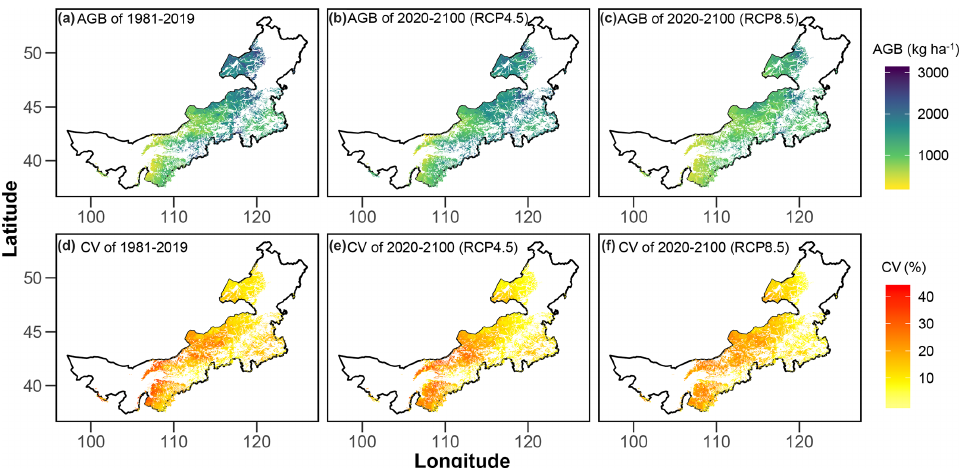
Figure 5. Spatial patterns of Inner Mongolian grassland aboveground biomass (AGB) and the uncertainties in terms of coefficient of varia- tions (CV). The upper panels show the average gridded AGB over 1981–2019 (a) and under two climate change scenarios (RCP4.5 b and RCP8.5 c ) over 2020–2100. The lower panels (d, e, f) exhibit the associated CV of the upper panels. Please note that these estimations were derived from simulations without considering the atmospheric CO 2 enrichment effects on AGB.